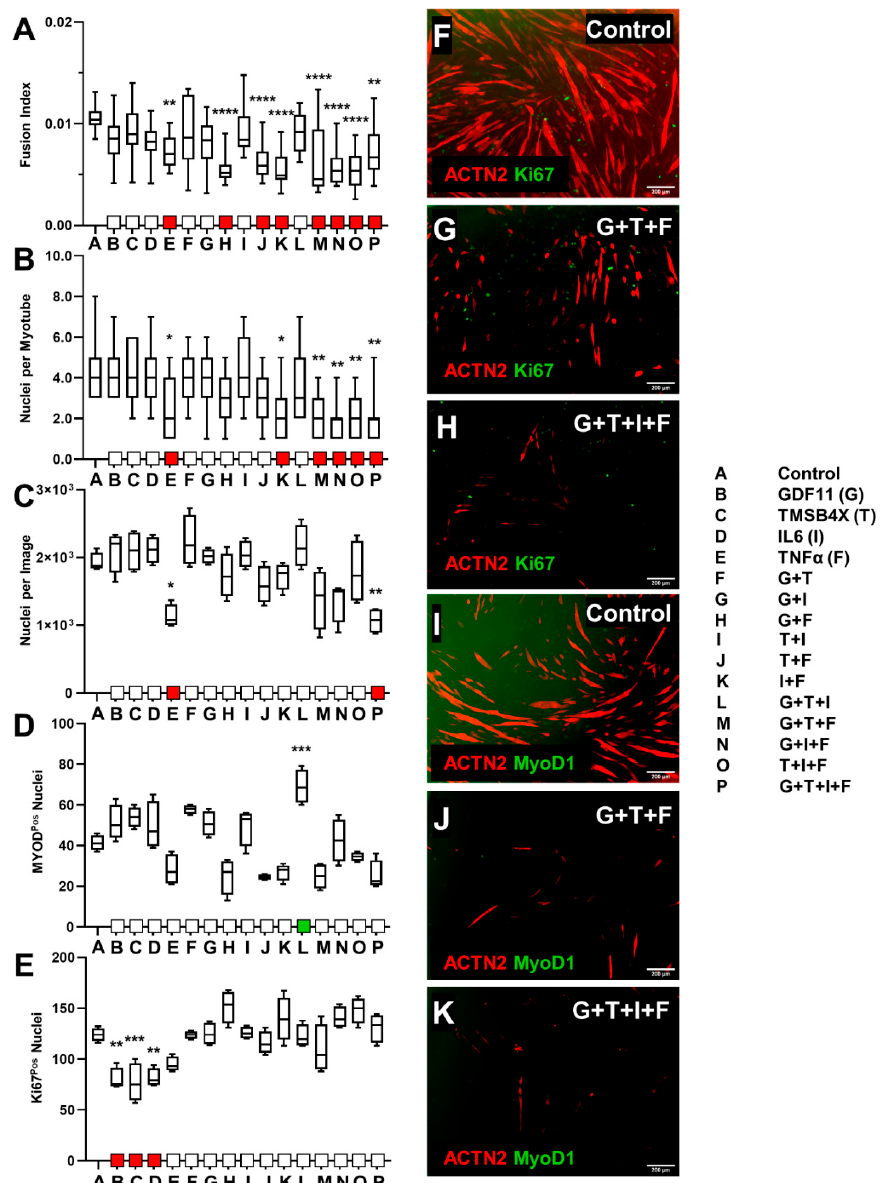
Figure 4. Determination of efficacy of C2C12 differentiation in conjunction with the exposure to ligand combinations. C2C12s were differentiated for 7 days and treated with combination ligands of GDF11 (G), TMSB4X (T), IL6 (I), and TNF- α (F) at 10 ng/mL for seven additional days. ( A ) Fusion index was calculated from total myotube nuclei vs. total nuclei ( n = 16, mean + SD). ( B ) Multinucleation of C2C12 myotubes were quantified ( n = 11, mean + SD). ( C ) Nuclear density was evaluated from nuclear count per field of 5x microscopy ( n = 4, mean + SD). ( D ) C2C12 exposed to ligand combinations were stained to express nuclear MYOD1 ( n = 6, mean + SD). ( E ) Cells were stained with Ki67, and where similarly quantified based on average total nuclear count ( n = 6, mean + SD). ( F ) ACTN2 and Ki67 immunostaining of control cells. ( G ) Cells exposed to GTF showed decreases in fusion index and myonucleation levels, although no change in nuclear density and Ki67+ expression was detected. ( H ) GTIF supplementation significantly reduced skeletal muscle differentiation pa-